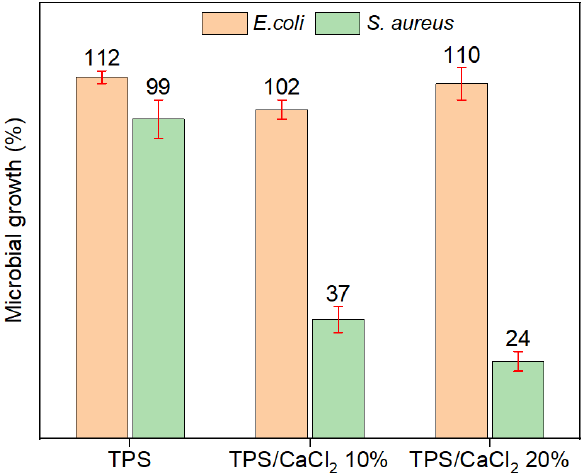
Figure 6. Microbial growth (%) dependent on the initial percentage of CaCl 2 in composite films. 100% is relative to the value for positive control sample (maximal bacterial growth).